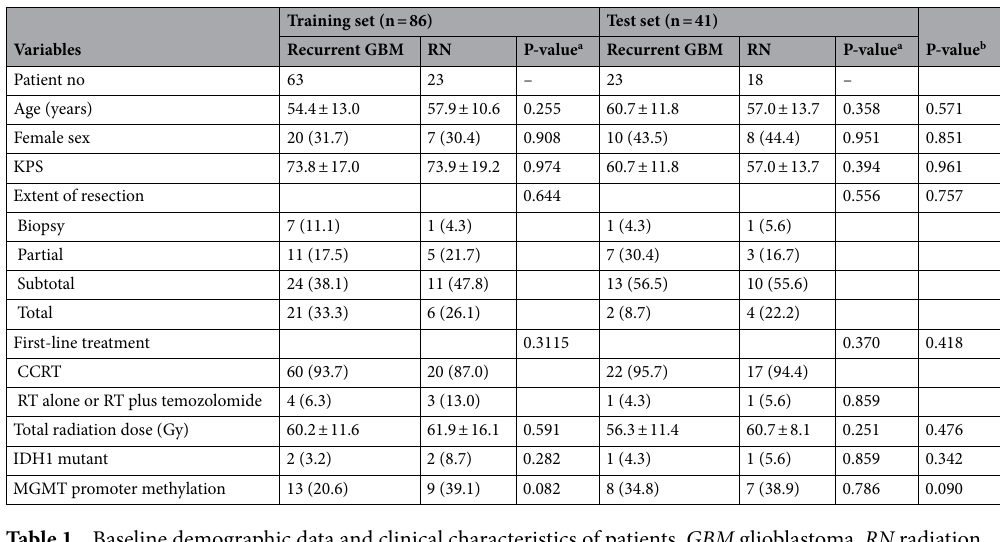
Table 1. Baseline demographic data and clinical characteristics of patients. GBM glioblastoma, RN radiation necrosis, KPS Karnosfky performance status, MGMT oxygen 6-methylguanine DNA methyltransferase. Data are presented as either mean ± standard deviation or numbers of patients (%). a Calculated from Student t test for continuous variables and Chi-square test for categorical variables for comparison of recurrent GBM and RN in training and test sets. b Calculated from Student t test for continuous variables and Chi-square test for categorical variables for comparison of training and test sets.